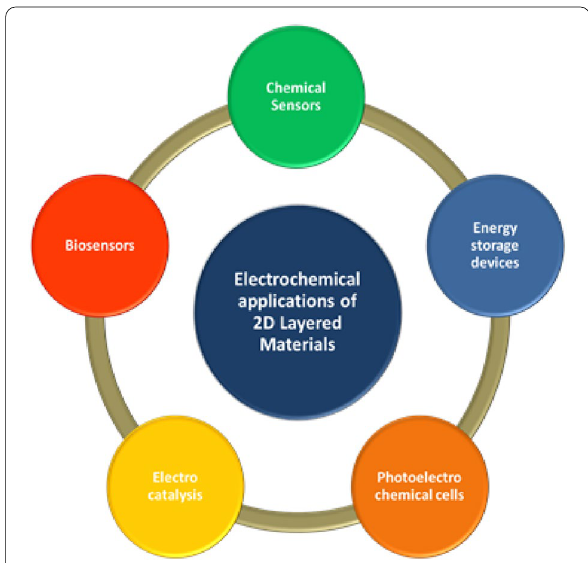
Fig. 8 Schematic overview of electrochemical applications of 2D-layered